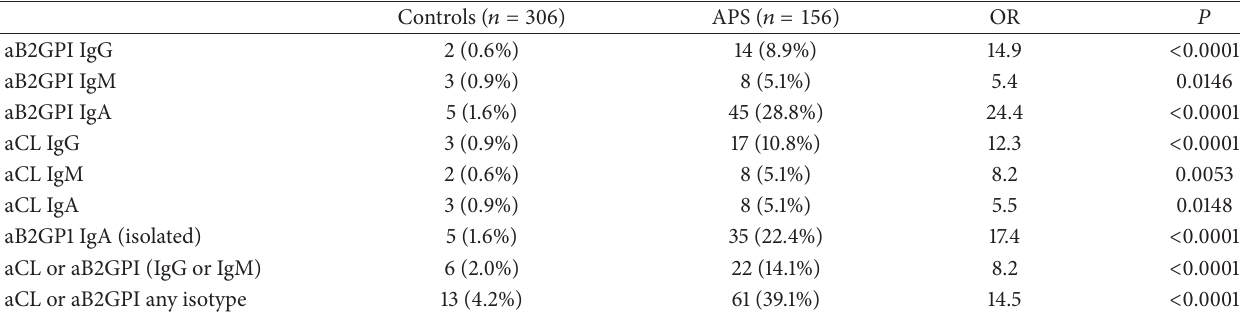
Table 3: Positive aPL antibodies in C-APS patients versus controls.